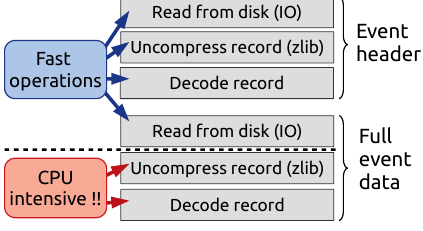
Figure 1. The six steps needed for reading an LCIO event: I / O read, uncompression and bu ff er decod- ing, executed for both, the event header and the full event